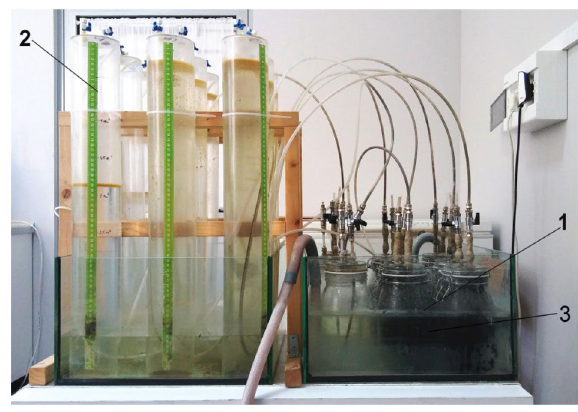
Fig. 1 Fermentation setup used in experiment: 1. glass reactors, 2. cylindrical vessel collecting biogas, 3. water bath chamber enabling mesophilic conditions in